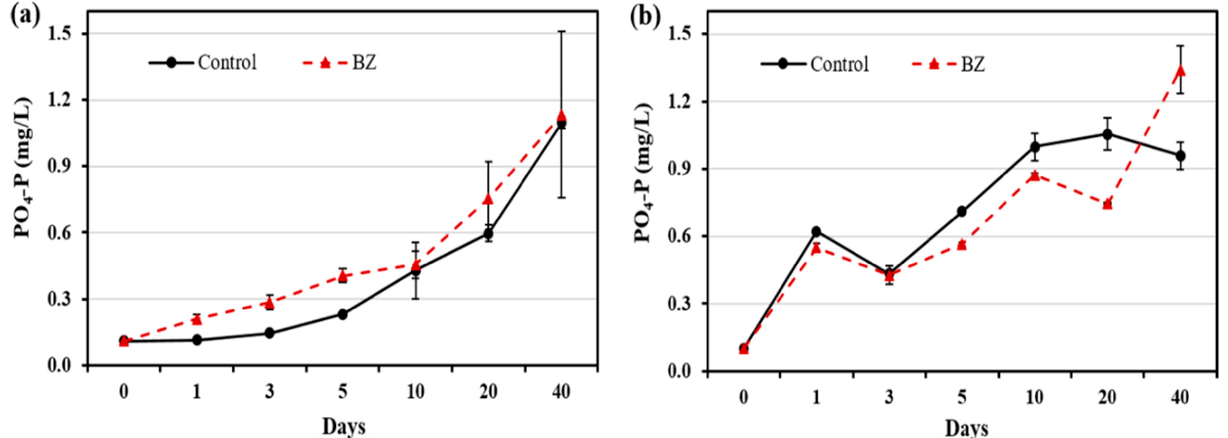
Figure 2. Changes in phosphate concentration at different times in ( a ) overlying water and ( b ) pore water. All analytical measurements were performed in triplicate and error bars indicate the standard deviation of the mean.